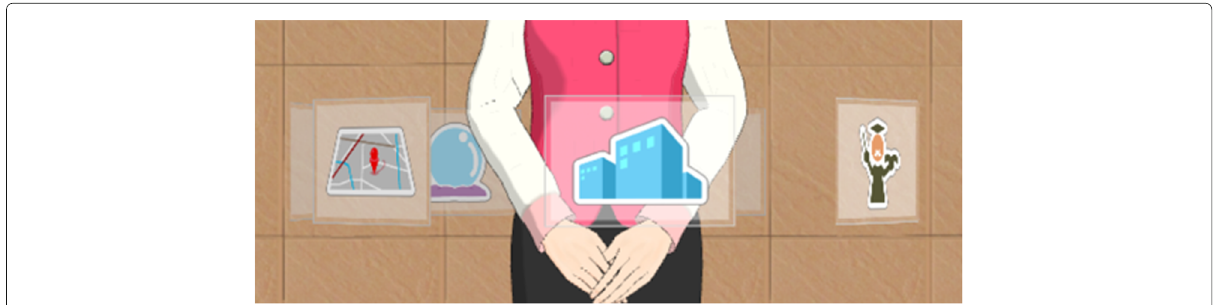
Fig. 8 Presentation of interactive content in icon